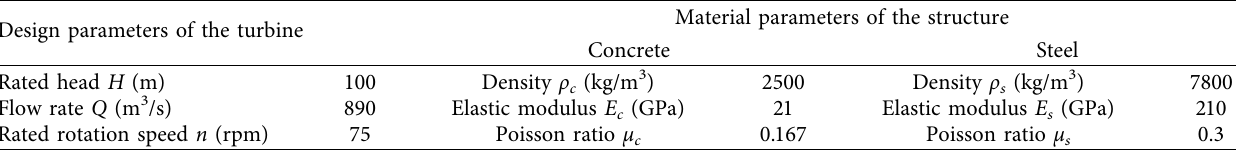
Table 1: Computational